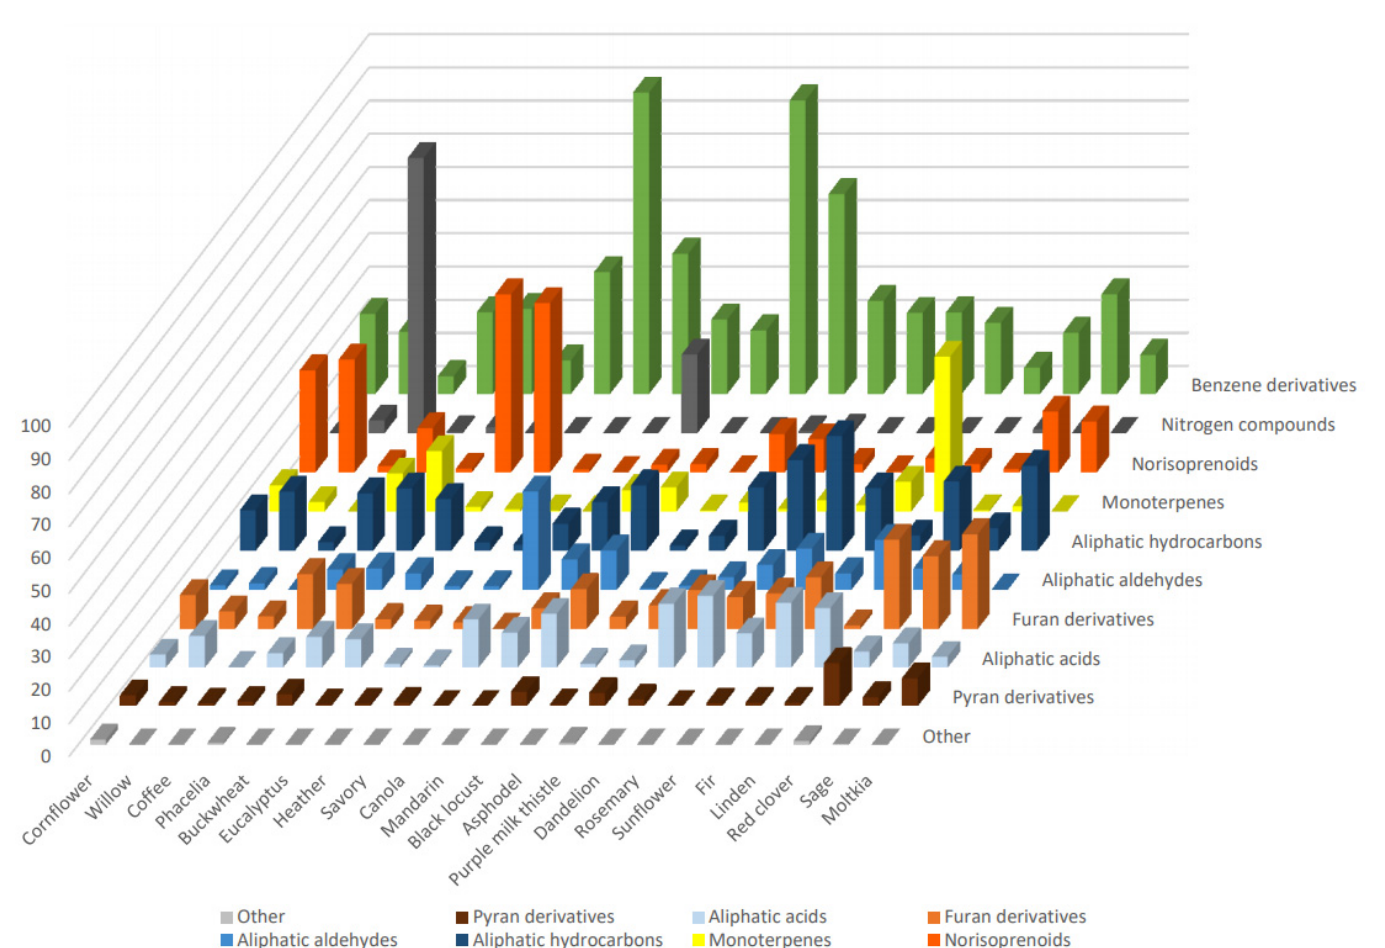
Figure 1. The overall percentages of the different volatile organic compounds (VOCs) structural groups in the analyzed honey types.